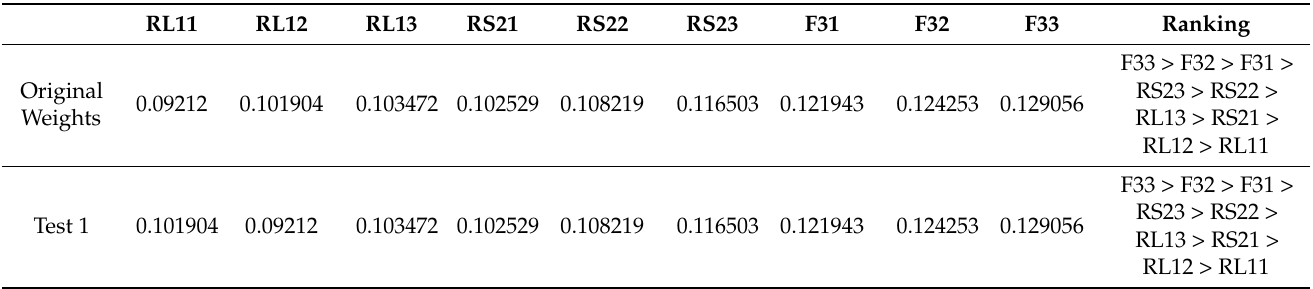
Table 8. Results of sensitivity analysis for scenario